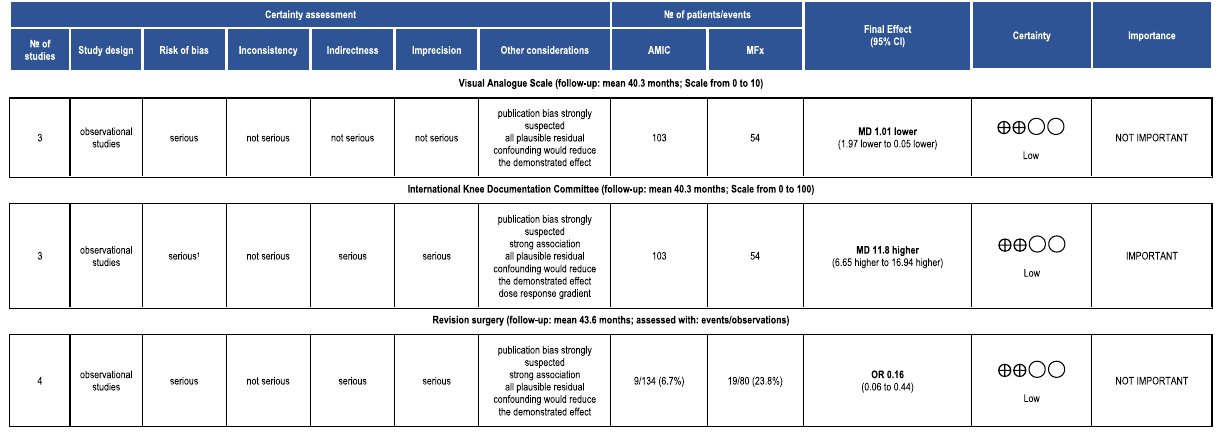
medium-sized cartilage defects of the knee 60 .